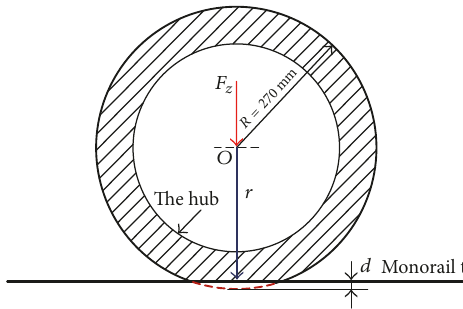
Figure 4: Schematic diagram of compressed wheel.